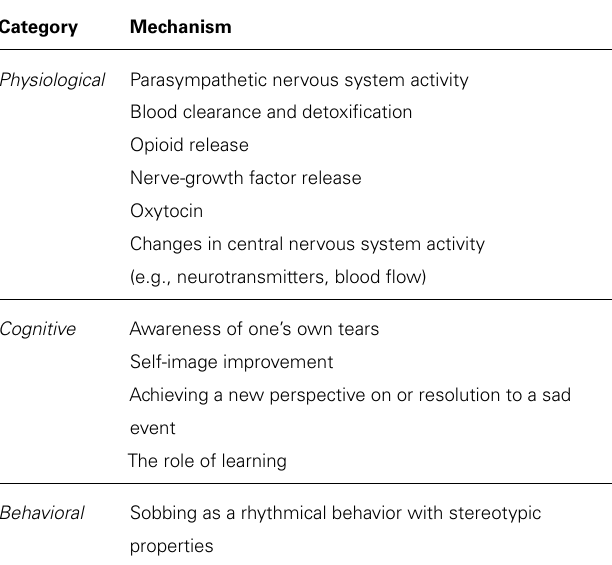
Table 1 | Proposed mechanisms that underlie the direct relationship between crying and mood